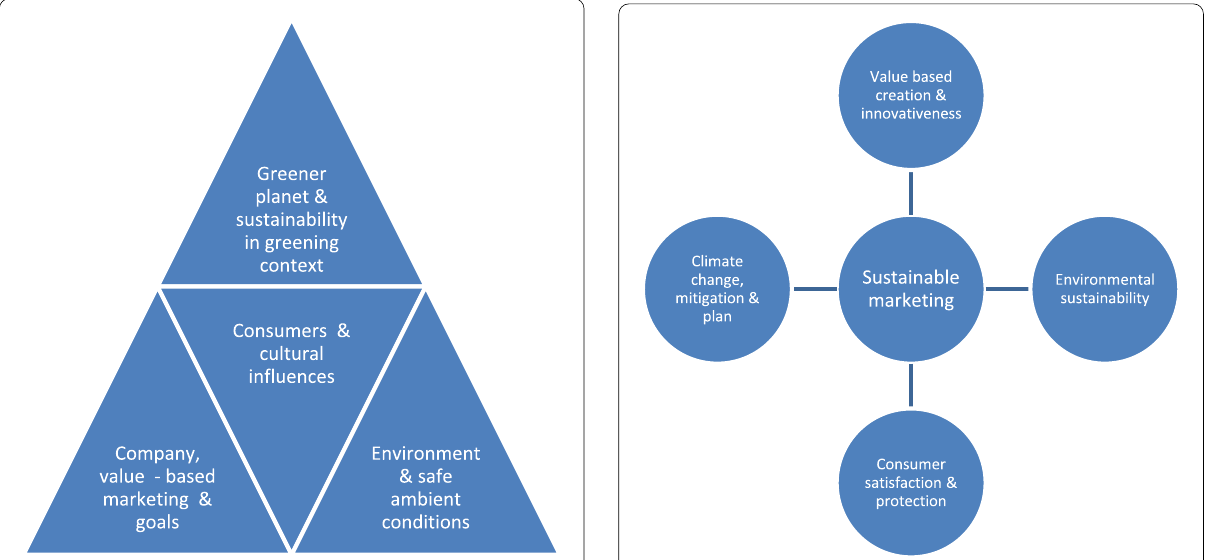
Fig. 5 Proposed Model of Sustainable Marketing: ‘Appendix 1 in Fig.